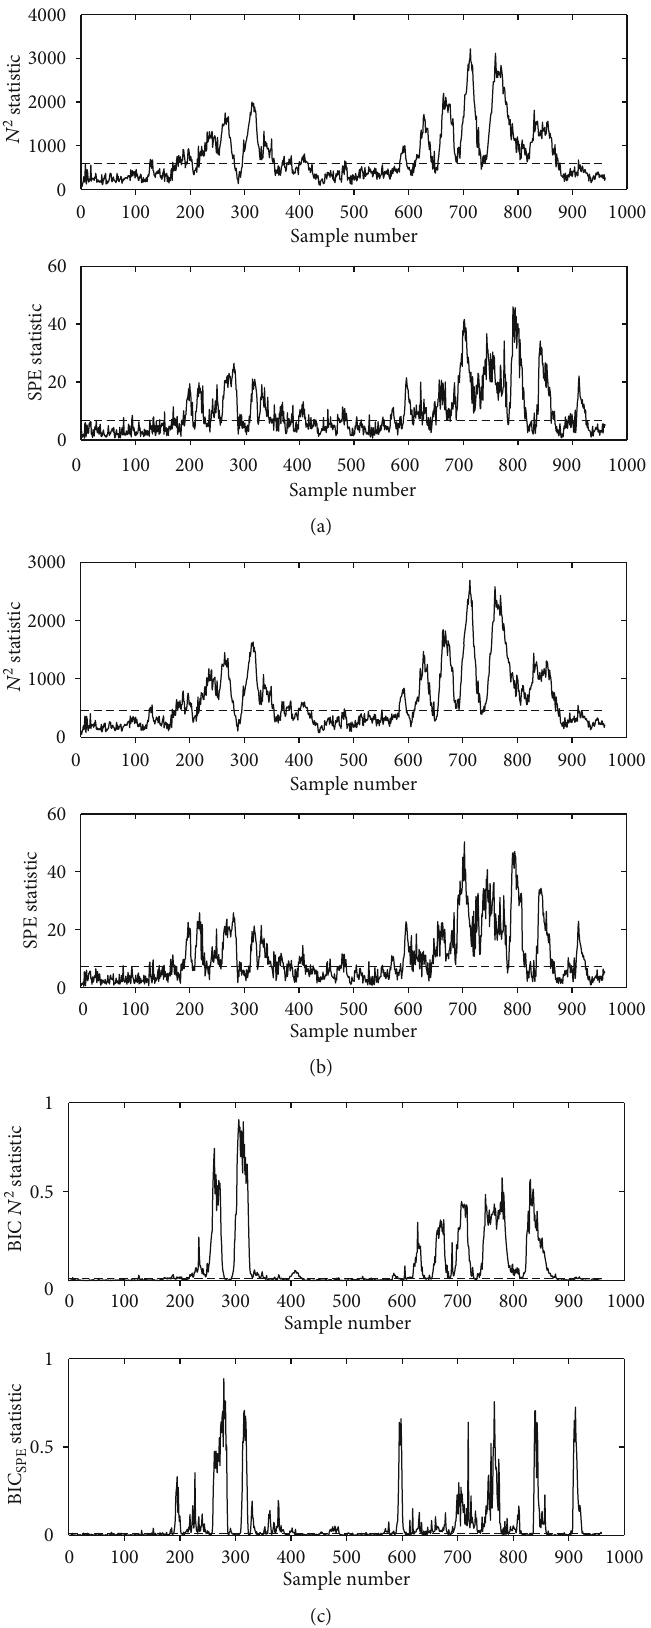
Figure 6: Fault detection results: (a) NMF method; (b) PNMF method; and (c) MPNMF